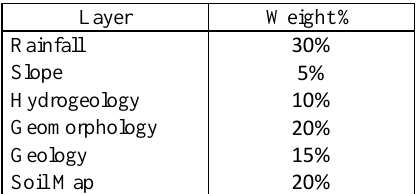
Figure 5. Reclassified rainfall map